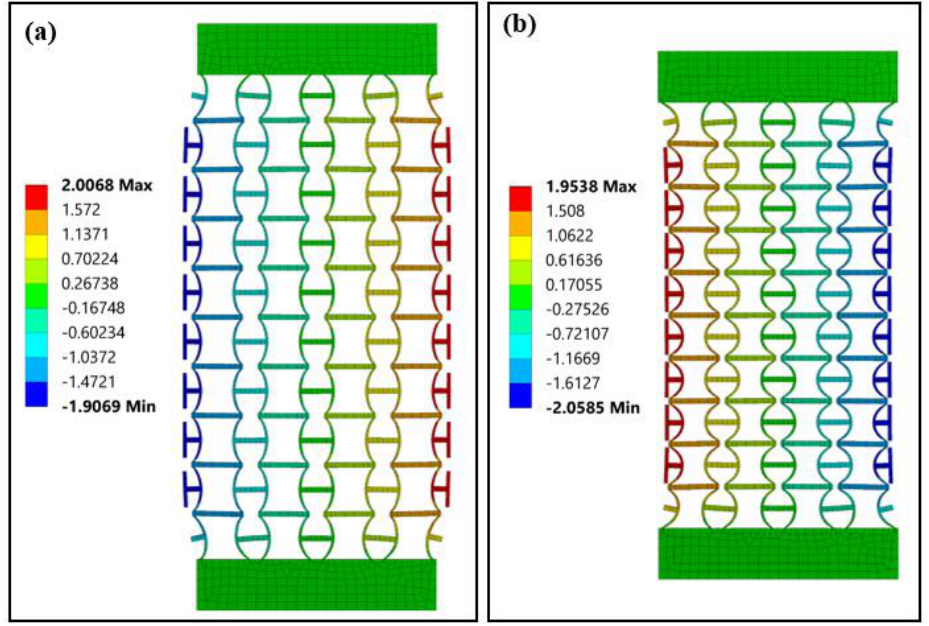
Figure 6. Transverse displacement (unit: mm) distributions of the structure model under ( a ) tension and ( b ) compression.